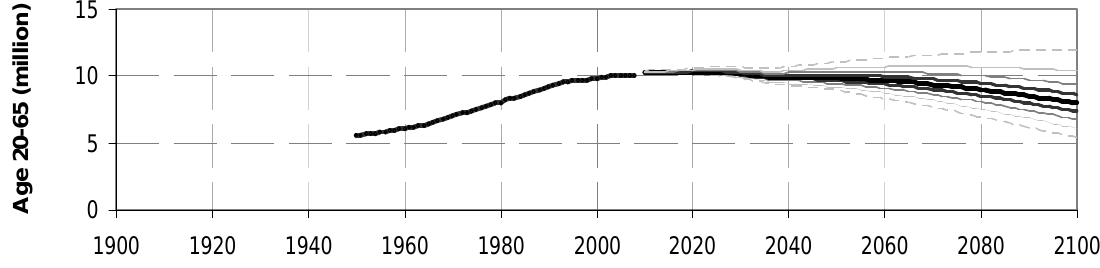
Figure 8. Probabilistic Forecast of the development of the Dutch working age Population